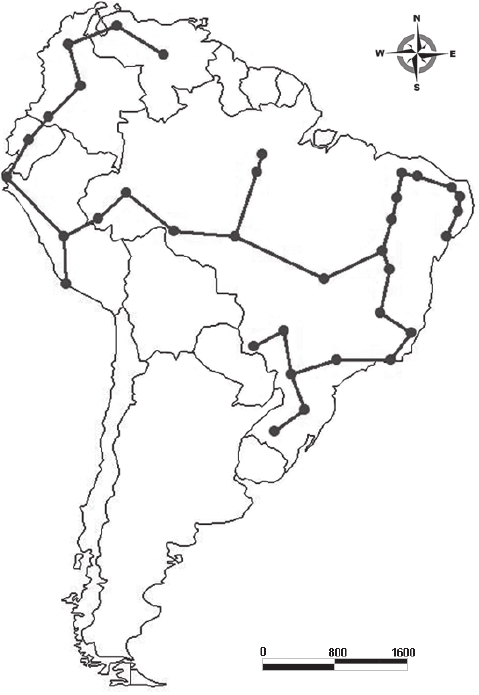
Fig. 3 - Individual track of Eremotherium laurillardii